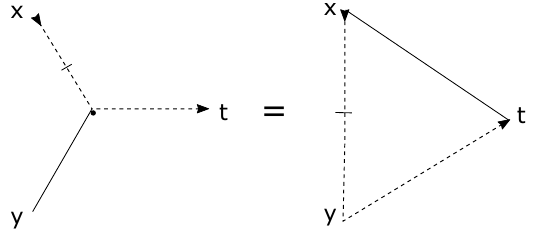
Figure 9 . Star-triangle relation (4.30). Differently from figure 8, there is no action of the R -matrix, as there are no spinors to mix ( n = 0 2